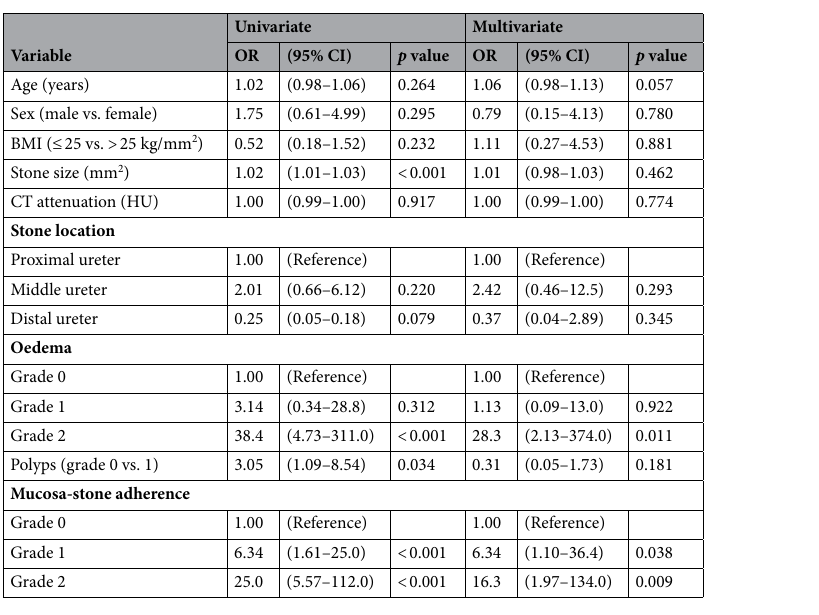
Table 5. Predictive factors of prolonged operative time (≥ 90